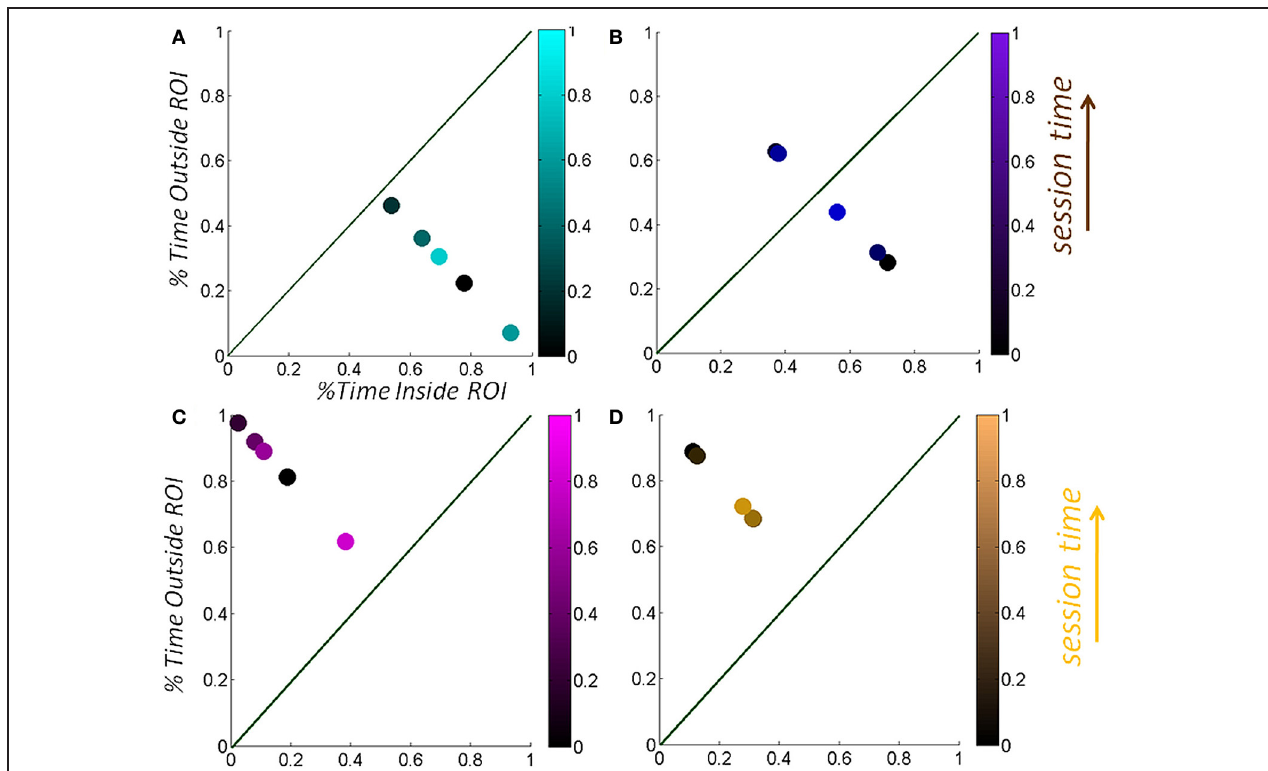
FIGURE 10 | Temporal progression of the validation metric as a function of session time-length. (A,B) Quantification of the percentage of session time that the hand spent inside the vRoI (goal-contacting) vs. outside the